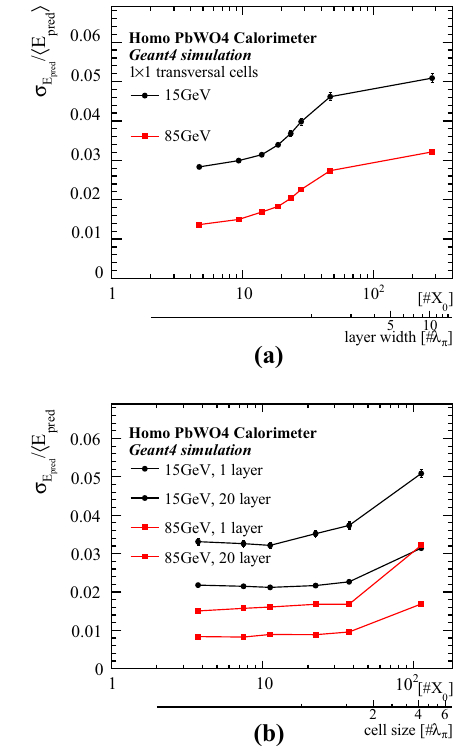
Fig. 6 Energyresolutionasafunctionofthelongitudinal( a )andtrans- verse ( b ) granularity. Two different particle energies are considered: 15GeV (black circles), and 85GeV (red squares). In the upper plot, no transverse segmentation is used, while on the bottom, two different lon- gitudinal segmentations are shown: 1 layer (dashed lines) and 20 layers (solid lines)